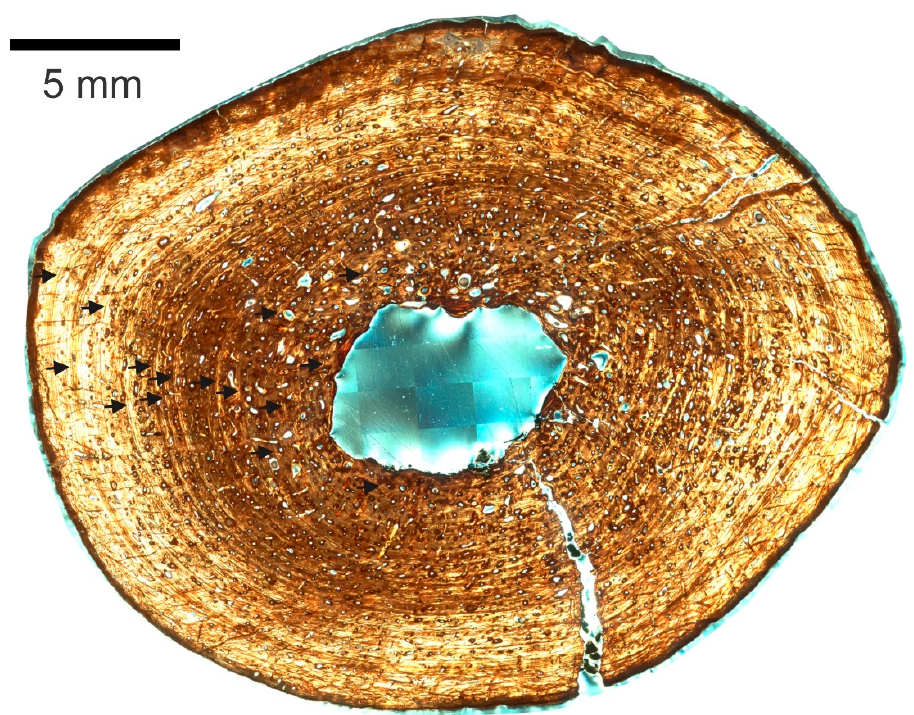
Figure 9. Mid-diaphyseal transverse thin section of the left femur of NJSM 23368, H. rogersii , slide 2 under CPL. Fifteen growth cycles are visible (arrows); however, they are variably preserved throughout the section, and several cannot be traced completely around. Scale bar is 5